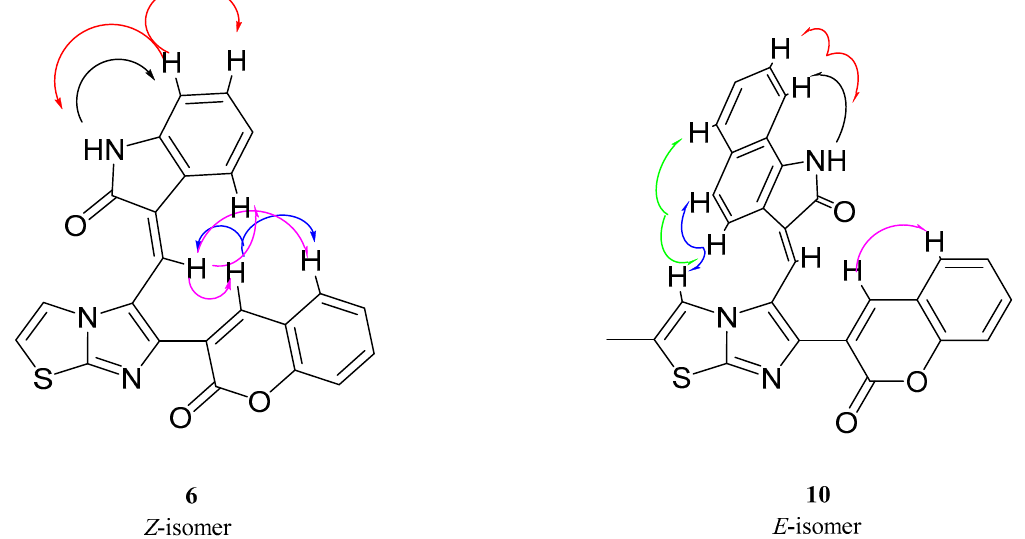
Figure 1. E and Z isomers of 3-(imidazo[2,1-b]thiazol-6-yl)-2H-chromen-2-one